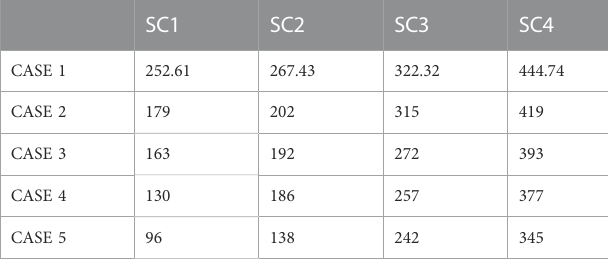
TABLE 1 Comparison of different cases in term of operating